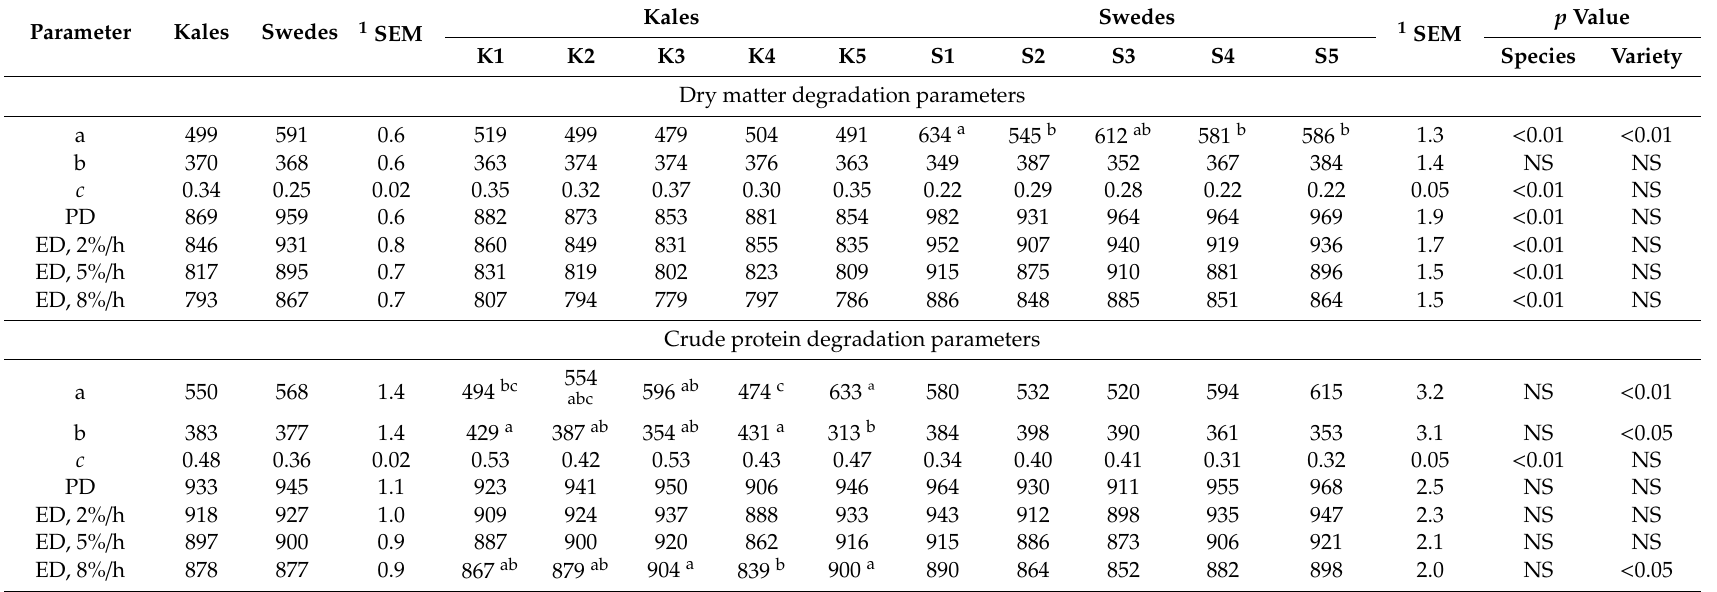
Table 2. In situ ruminal digestion kinetics, potential degradability (PD) and e ff ective degradability (ED, considering a passage rate of 2%, 5%, and 8% per hour) of five varieties of kale (from K1 to K5) and swedes (from S1 to